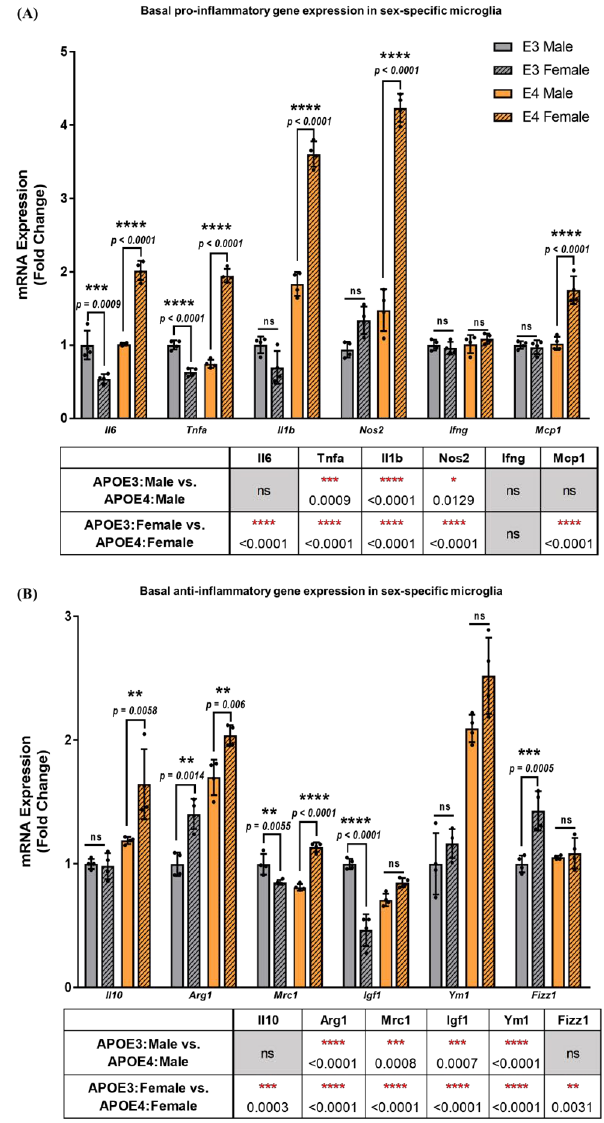
Figure 5. Basal pro − and anti − inflammatory gene expression in sex − specific microglia is dependent on both the APOE genotype and sex: ( A ) basal pro − inflammatory and ( B ) anti − inflammatory gene expression was evaluated in non − stimulated sex − specific microglia from APOE3 and APOE4 genotypes. Gene expression between genotypes and sexes was analyzed using two − way ANOVA (N = 3 isolations, n = 6 plates). Data are represented as the mean ± standard deviation. *, **, ***, and **** indicate statistical significance for the comparison and denote p < 0.05, 0.01, 0.001, and 0.0001, respectively. ns = not statistically significant ( p >